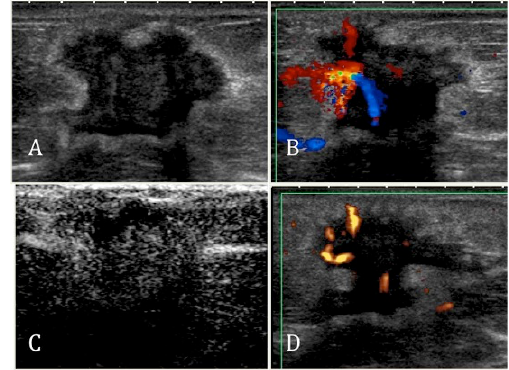
Figure 1 - A fibroadenoma found in the left breast of a 47-year- old woman. A) Gray-scale image showing an irregular, micro- lobulated mass (BI-RADS 4). B) Color Doppler image showing a peripheral regular artery. C) After contrast injection, we observed moderate peripheral enhancement. D) An enhanced color Doppler image showing the same aspect as that shown for the non-enhanced color Doppler image in B. No additional arteries were observed. Power Doppler imaging was used only to produce clearer images for illustration purposes.